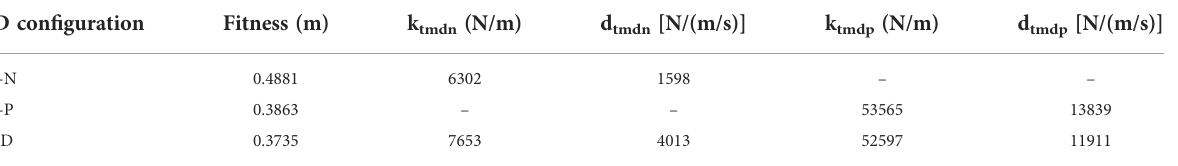
TABLE 4 TMD parameter optimization